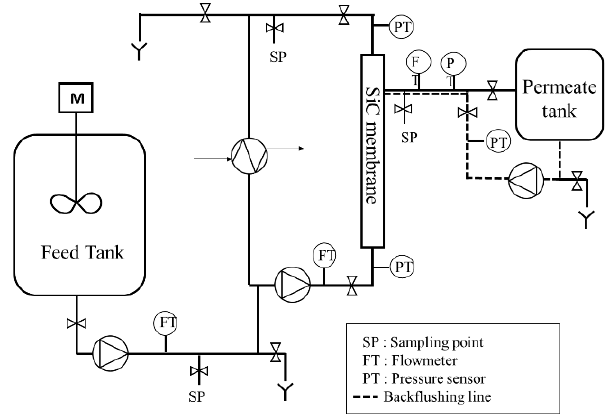
Figure 1. Simplified pilot plant scheme.